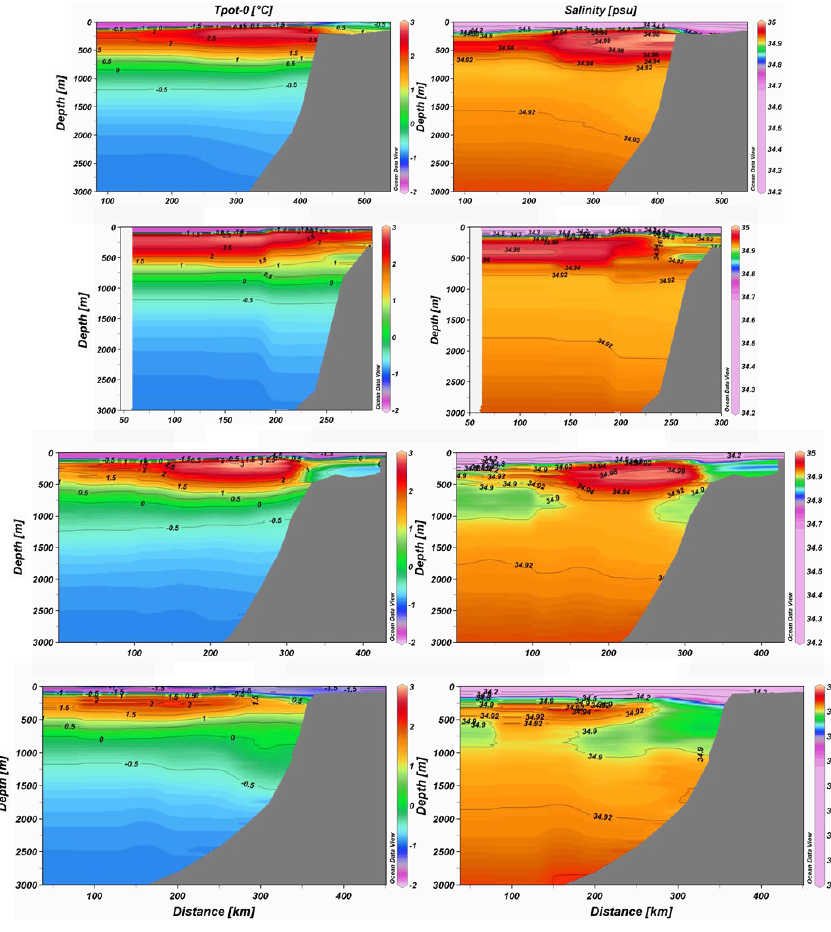
Fig. 11 . Potential temperature and salinity sections from the shelf into the deep Nansen Basin: upper panel – western Barents Sea; upper centre panel – Franz Josef Land; lower centre panel – eastern Kara Sea; lower panel – Laptev